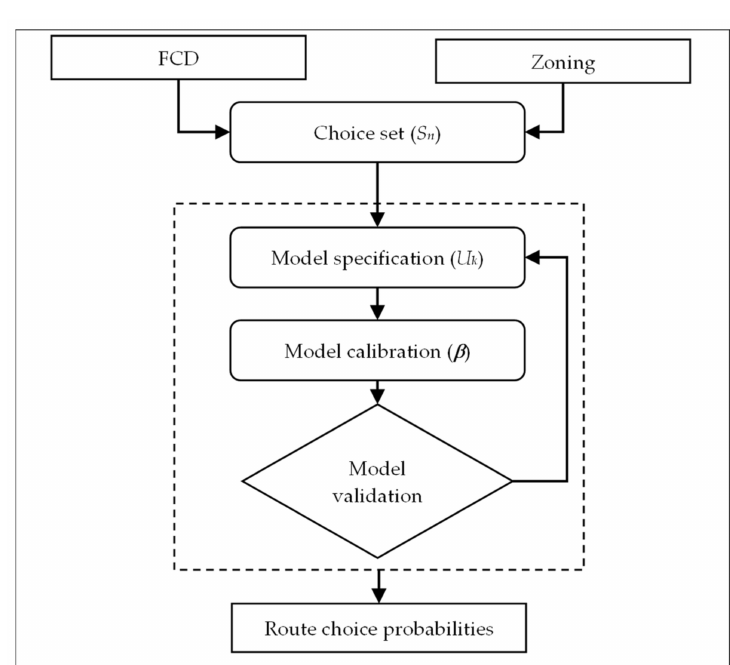
Figure 2. Route choice probabilities: procedure.